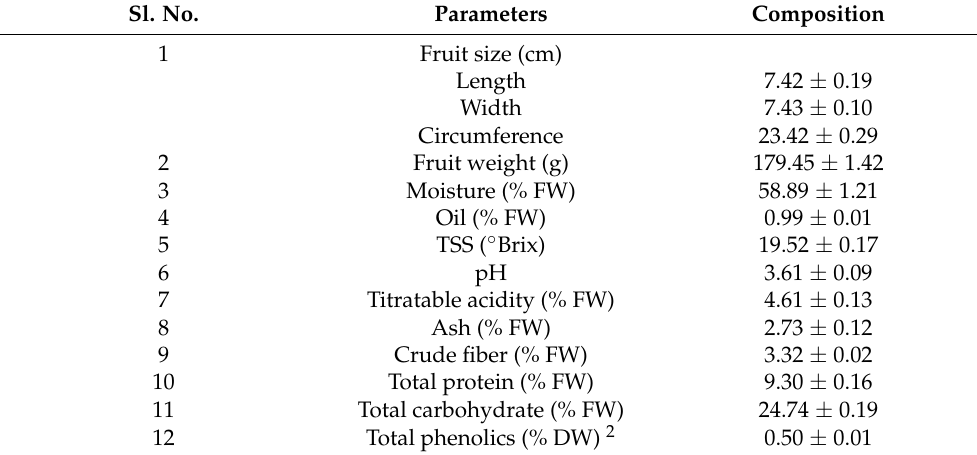
Table 1. Proximate and total phenolic composition of wood apple fruit pulp 1 . Sl. No. Parameters Composition 1 Fruit size (cm) Length 7.42 ± 0.19 Width 7.43 ± 0.10 Fruit weight